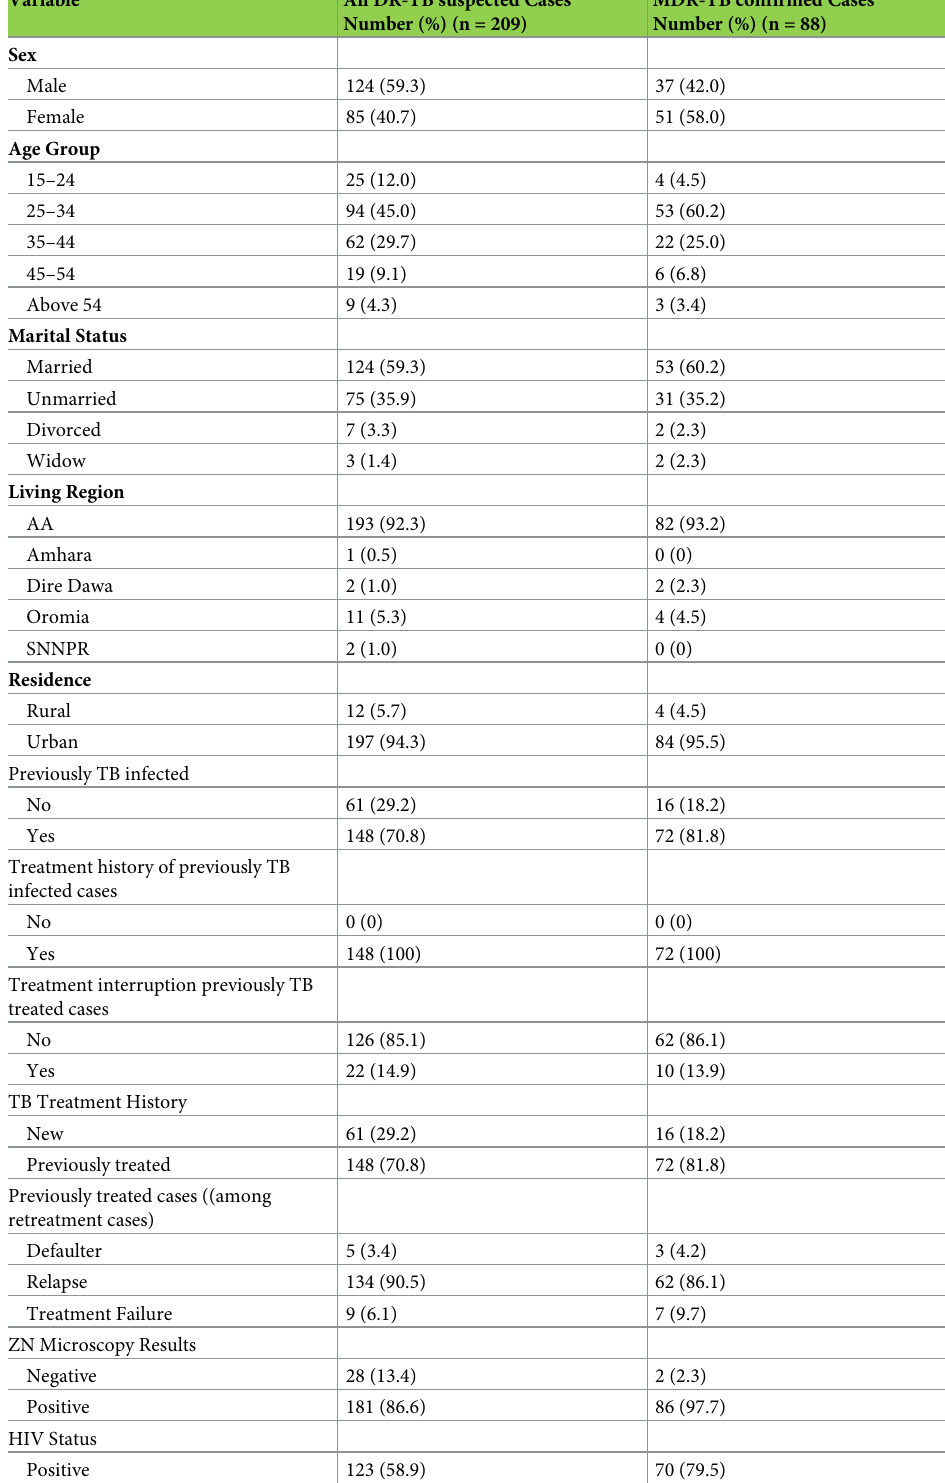
Table 2. Socio-demographic and TB-related characteristics of MDR-TB suspected and confirmed